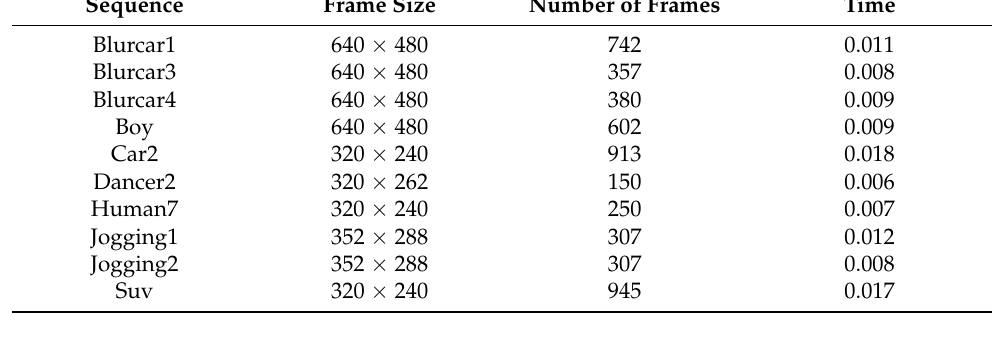
Table 4. Computation time of the proposed tracker’s learning rate module.